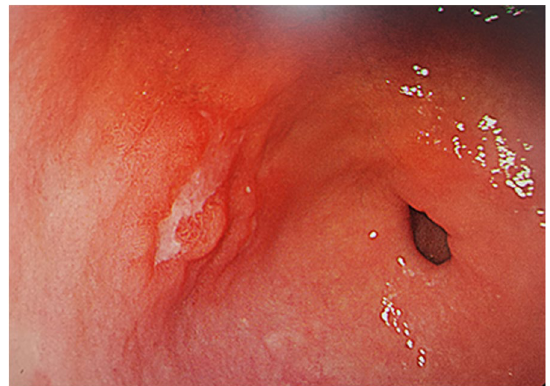
Fig. 1 The electronic esophagogastroduodenoscopy performed at our hospital revealed a 1.8 cm 1.5 cm lesion at the anterior wall of × the gastric antrum, with ulcers on the surface